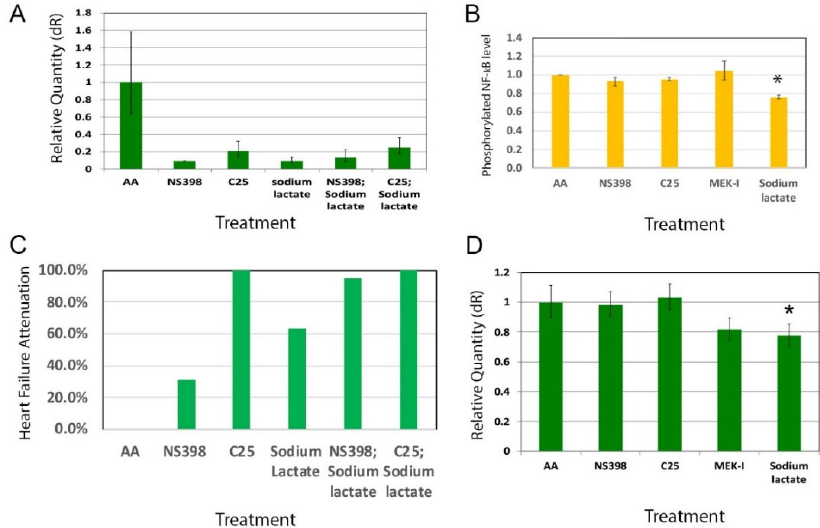
Figure 7. Sodium lactate mechanisms. ( A ) COX-2 gene expression by qRT-PCR in zebrafish embryos treated with AA alone or with test chemicals: NS398, C25, sodium lactate, NS398; sodium lactate, or C25; sodium lactate. Sodium lactate suppresses COX-2 expression. ( B ) Relative levels of phosphorylated NF- κ B in zebrafish embryos treated with different compounds. The quantification was done by measuring the pixels of the phosphorylated NF- κ B bands and were normalized by that of β -actin on three Western blot images using Photoshop. Sodium lactate treated embryos showed a significantly lower level of phosphorylated NF- κ B. (* indicates statistical significance by t -test, p = 0.001). ( C ) Additive effect of AHF attenuation by NS398 and sodium lactate. (Y axis: heart failure attenuation percentage). ( D ) Tnnt2 expression measured by qRT-PCR was significantly lower in the embryos treated with sodium lactate. (* indicates statistical significance by t -test, p <